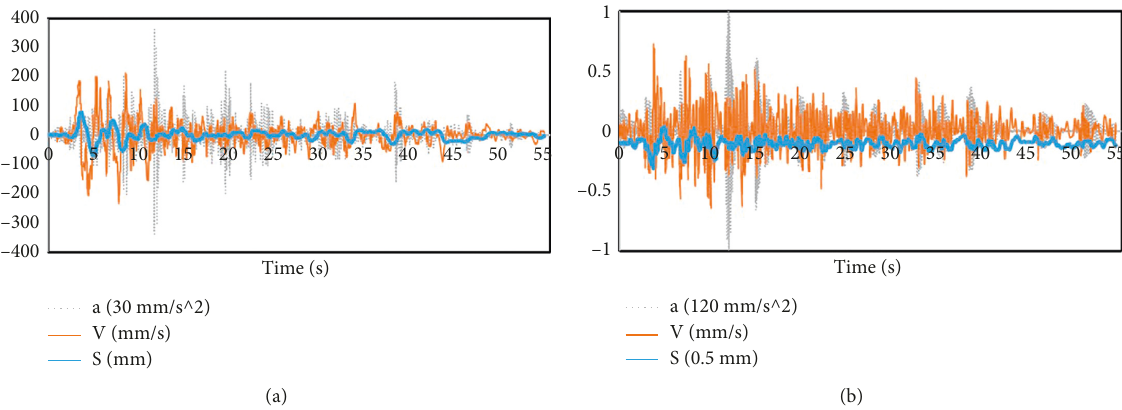
Figure 58: Time course curves of bearing deformation displacement, velocity and acceleration when TAF is input from Y direction. (a) Horizontal deformation. (b) Vertical